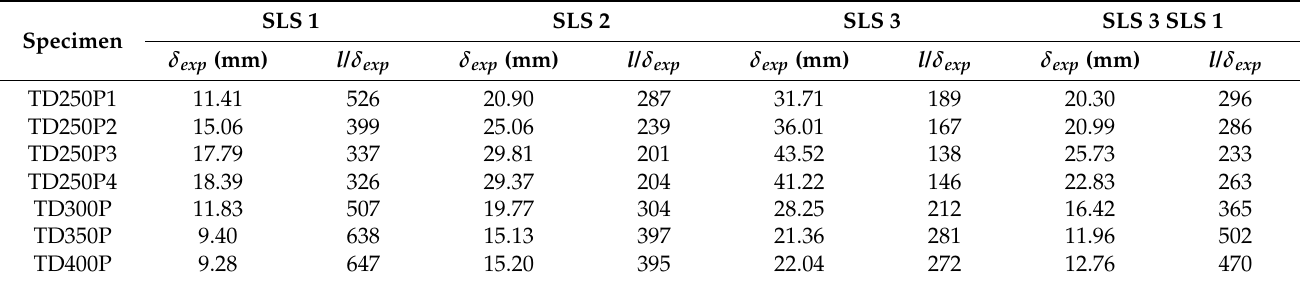
Table 5. Serviceability limit states (SLS) for deflection checks.